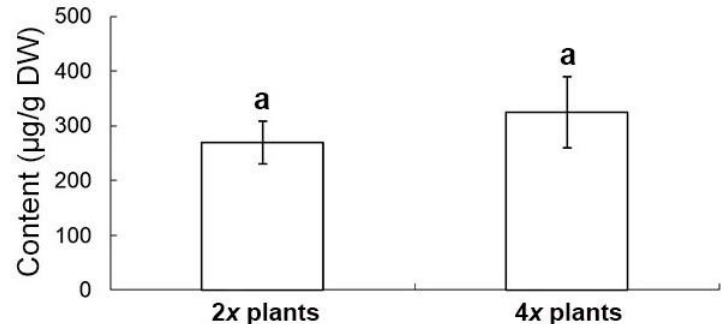
Figure 7. The salvianolic acid B content in shoots of 2 x and 4 x plants of Salvia miltiorrhiza . According to DMRT ( P ≤ 0.05), the means ± standard errors that followed by the same letter were regarded as not significantly different.